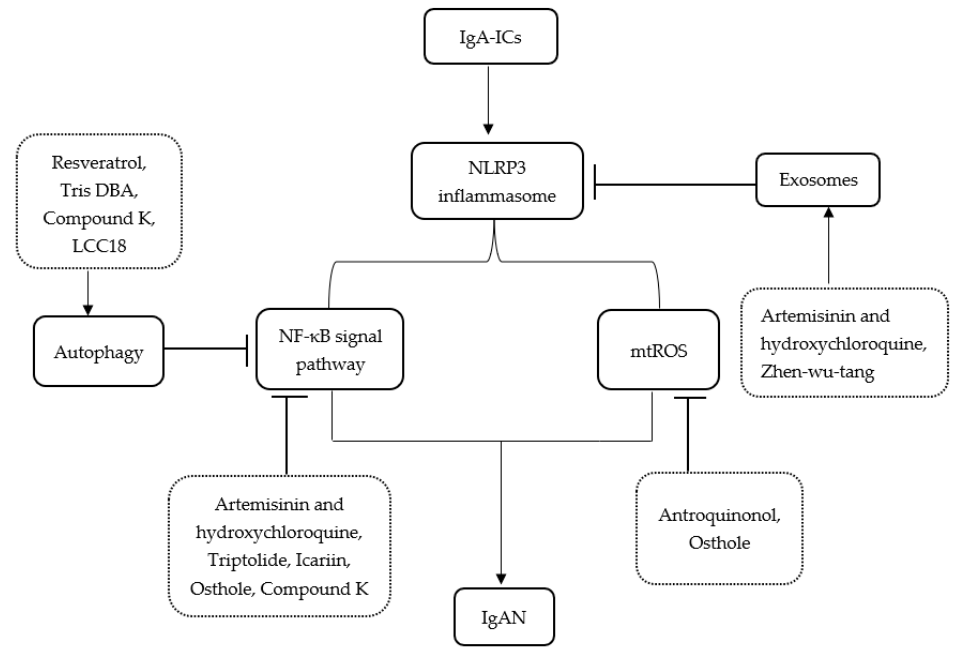
Figure 1. Schematic representation for the related pathways between IgAN and the NLRP3 inflammasome and the plausible mechanism of treatments. IgA-ICs, IgA immune complexes; IgAN, IgA nephropathy; Tris DBA, Tris dibenzylideneacetone dipalladium; ROS, reactive oxygen species.